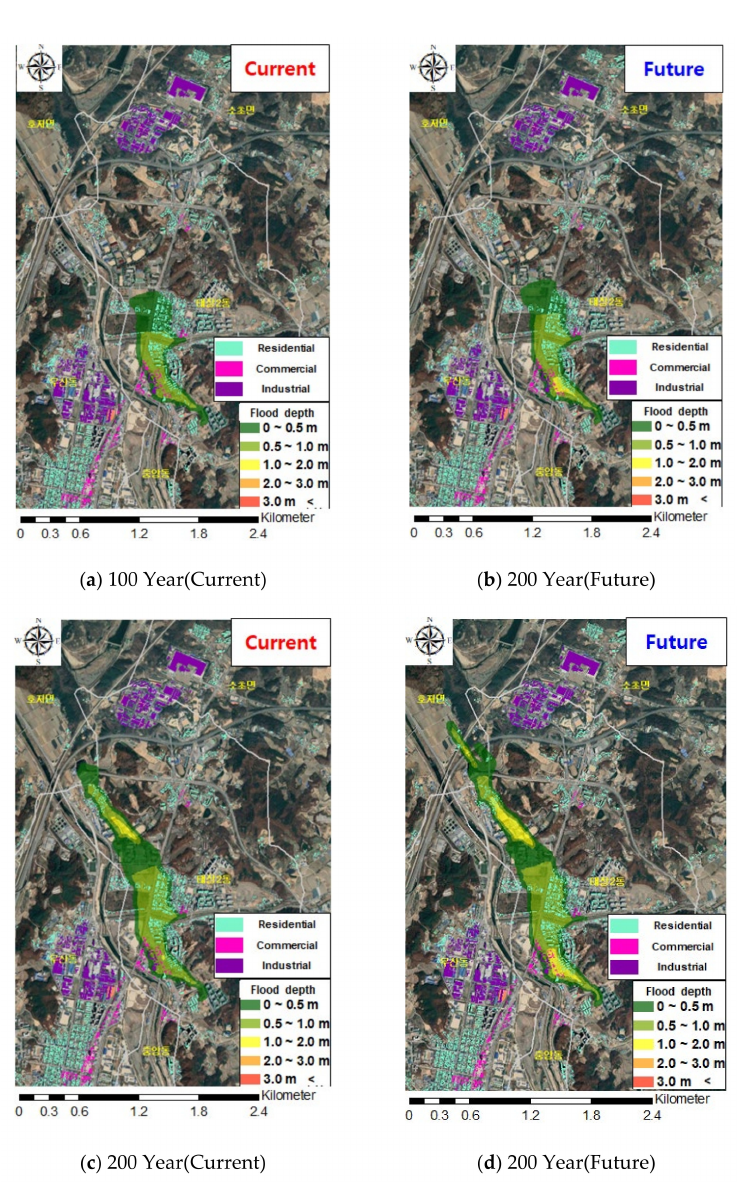
Figure 15. Result Flood Damage